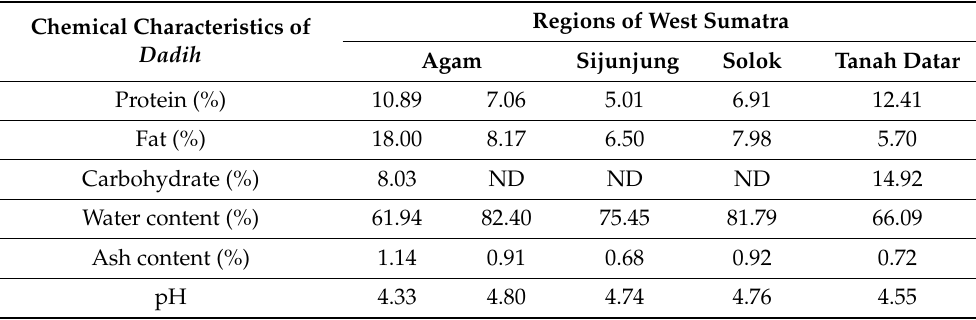
Table 3. Nutritional value of dadih —fermented buffalo milk from different regions in West